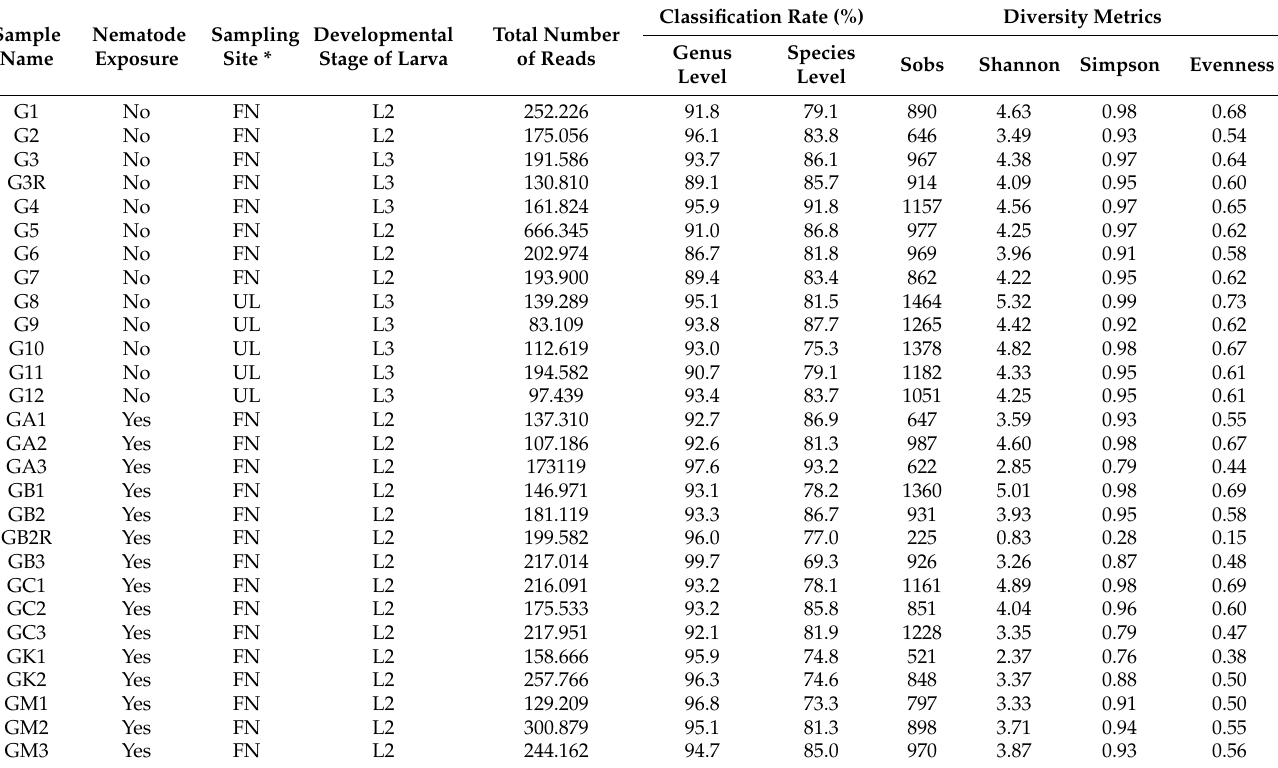
Table 1. Sampling sites, NGS sequencing statistics, and α -diversity metrics for the studied midgut bacterial